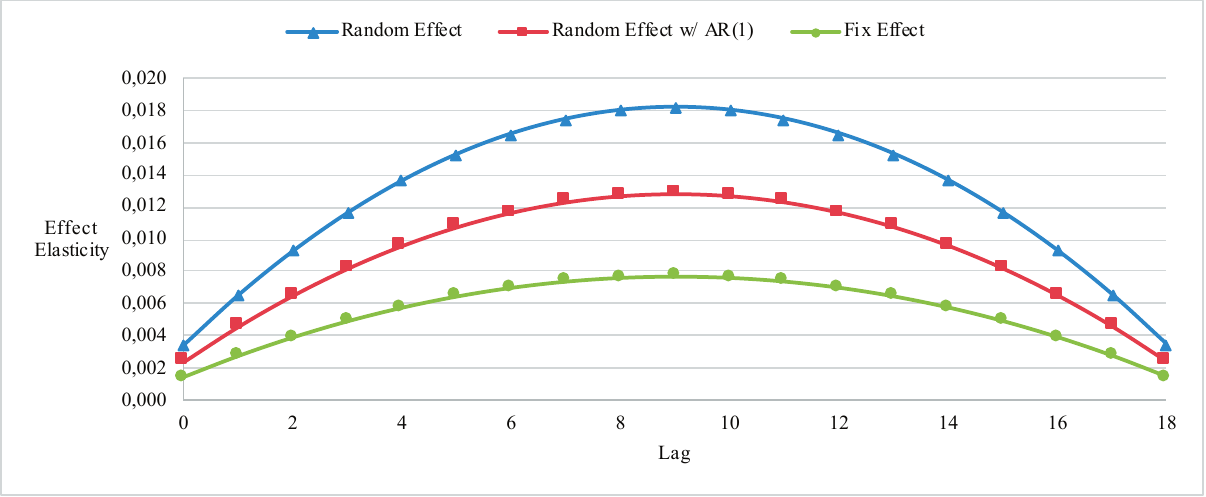
Figure 1. Distribution of single R&Dt-j effects in TFP specifications. Source: own elaboration. Note: FEff estimates are elasticities; REff esti- mates are marginal